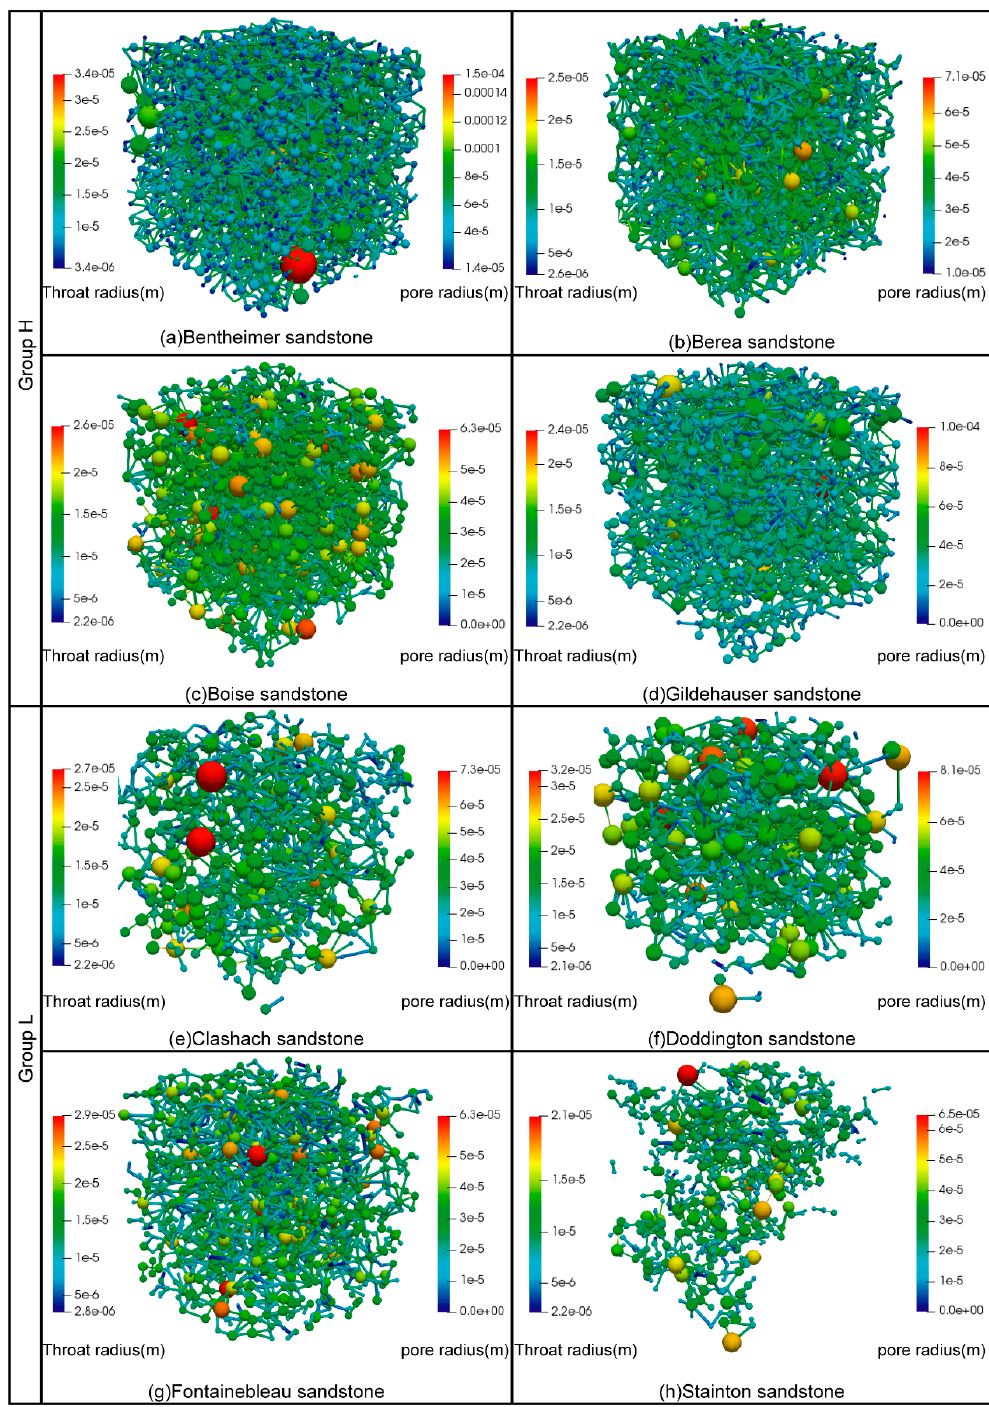
Figure 5. Pore network models from micro-computed tomography (micro-CT) scans of eight sandstone samples: ( a ) Bentheimer sandstone, ( b ) Berea sandstone, ( c ) Boise sandstone, ( d ) Gildehauser sandstone, ( e ) Clashach sandstone, ( f ) Doddington sandstone, ( g ) Fontainebleau sandstone, and ( h ) Stainton sandstone.